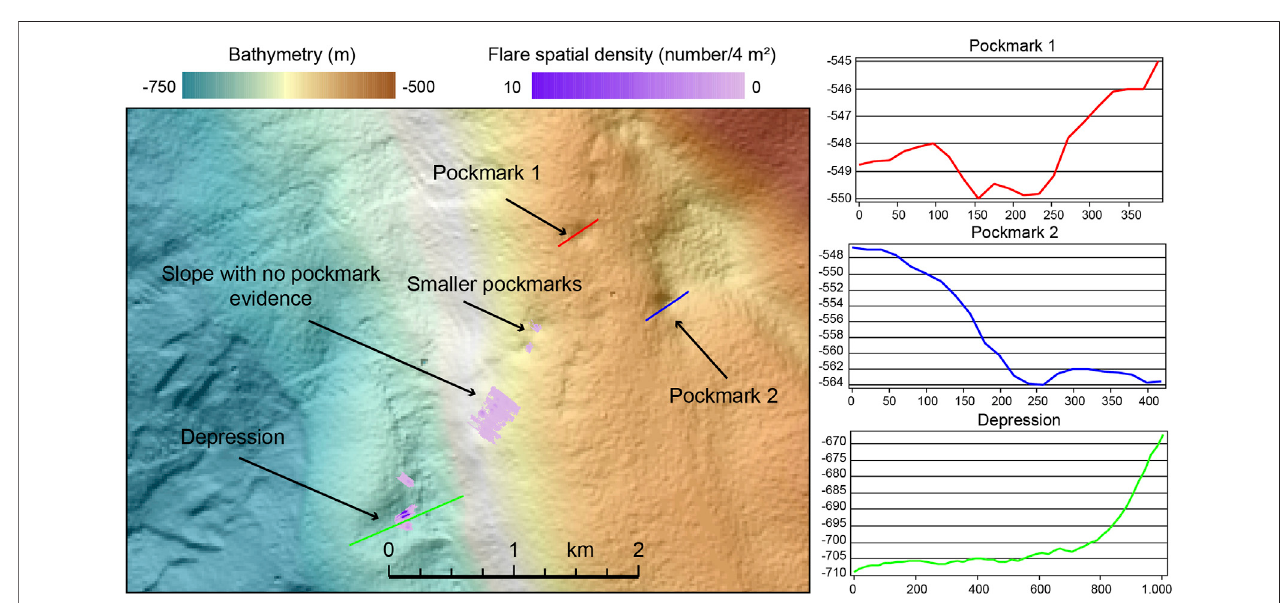
FIGURE 10 | Zoom in of the area of pockmarks and gas fl ares outlined in white in Figure 9A . On the right, bathymetric pro fi les of larger pockmarks, where no gas fl ares have been detected, and of the depression where gas fl ares are more concentrated. Note that fl ares are located above smaller pockmarks.